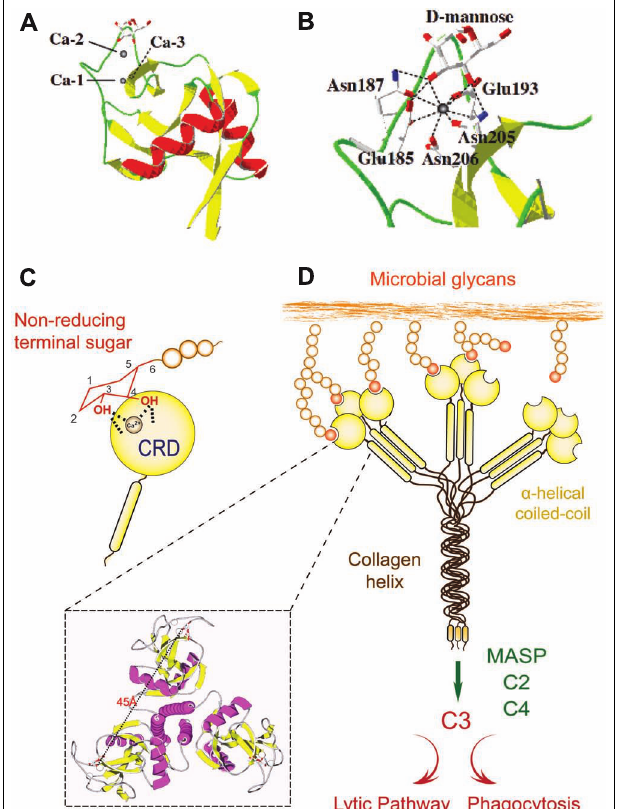
FIGURE 1 | Recognition and effector activities of the mannose-binding lectin (MBL). (A) A schematic representation of CTLD organization; (B) Crystallographic model of CTLD; ( C) Ca 2 + -dependent carbohydrate binding of CTLD.The CRD recognizes equatorial hydroxyls on C3 and C4 of non-reducing terminal mannose with participation of the Ca 2 + atom. ( D) The MBL trimer binds to ligands that are displayed about 45 Å apart on the microbial surface, and via association with the MASP) may activate the complement cascade, leading to opsonization or lysis of the microbe.